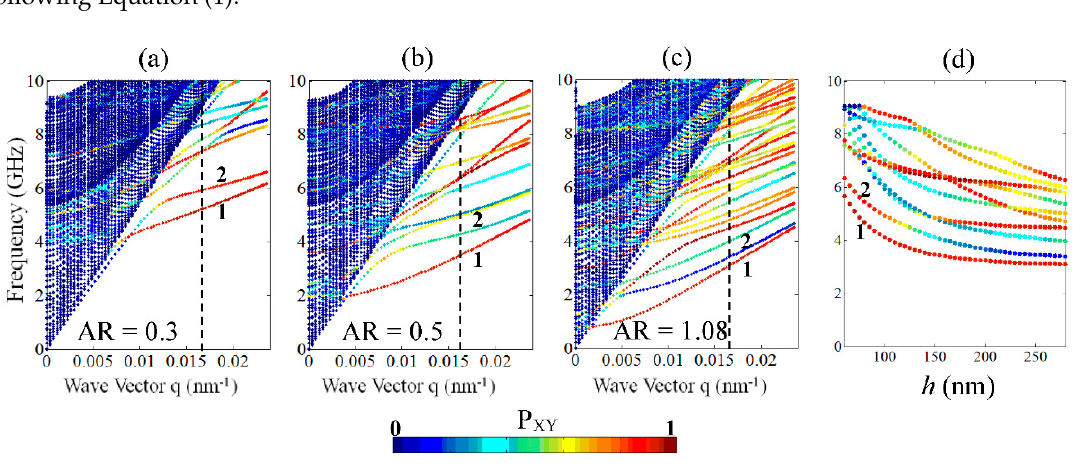
Figure 6. Dispersion curves for the direction parallel to the nanoridges with a fixed width of w = 250 nm and for different heights ( a ) h = 68 nm, ( b ) h = 135 nm, and ( c ) h = 270 nm. ( d ) Calculation of the first 10 branches at q = 0.0167 nm − 1 versus the height of the nanoridges. The color bar selects the modes of P xy polarization inside the nanoridges.